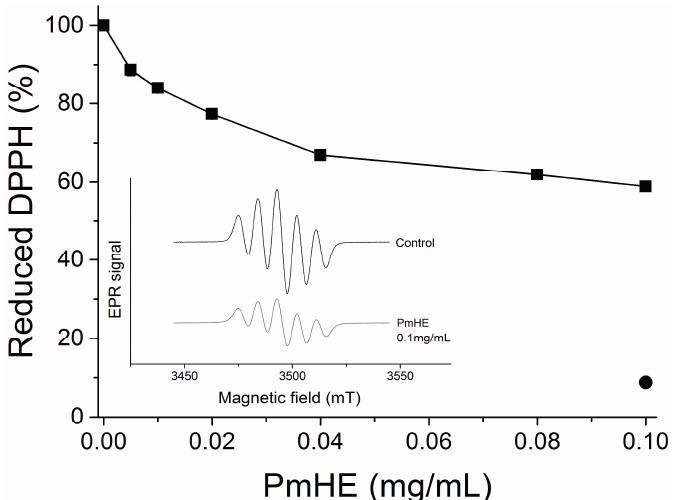
Figure 2. 1,1-Diphenyl-2-picrylhydrazyl (DPPH) reduction by P. major hydroethanolic extract (PmHE). DPPH solution was incubated with different concentrations of P. major extracts and absorbance was measured at 517 nm (closed squares). Quercetin (0.1 mg/mL) was used as standard (closed circle). The results were expressed as percentage in relation to DPPH solution, considered as 100%. Inset: Electron paramagnetic resonance (EPR) spectra of DPPH radical obtained in the absence of the extract (control) or in the presence of 0.1 mg/mL